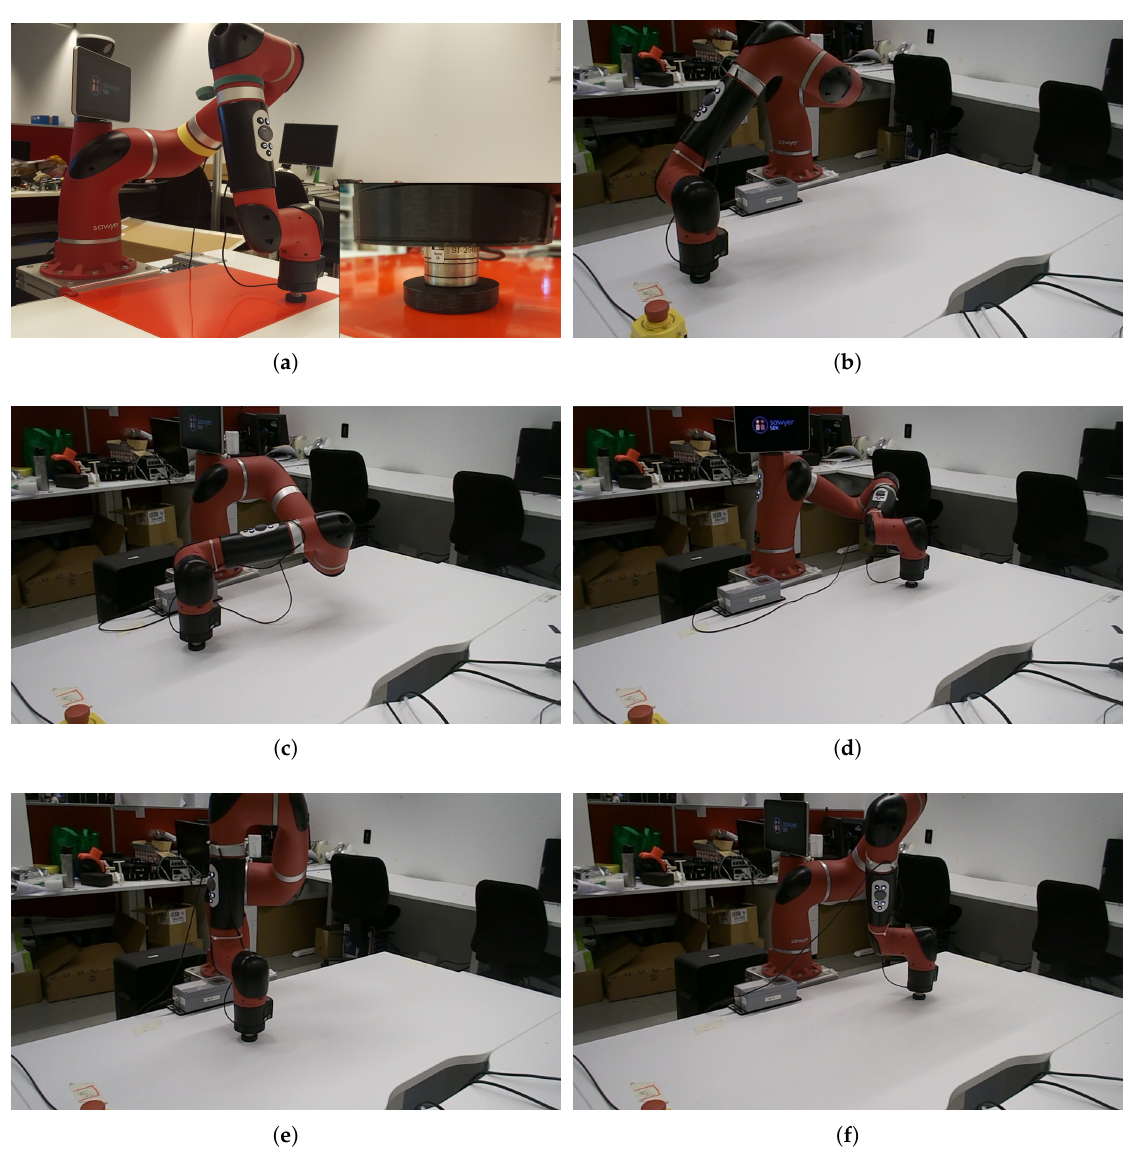
Figure 3. Sawyer polishing task experiment: ( a ) setup: 7R manipulator with a force sensor attached to the robot end-effector, a tool consisting of a cylinder of 43 × 43 × 10 mm attached to the sensor and a flat surface target, ( b ) initial pose with minimal manipulability for both tests, ( c , d ) proposed SCO algorithm, ( e , f ) “Simple Planner”